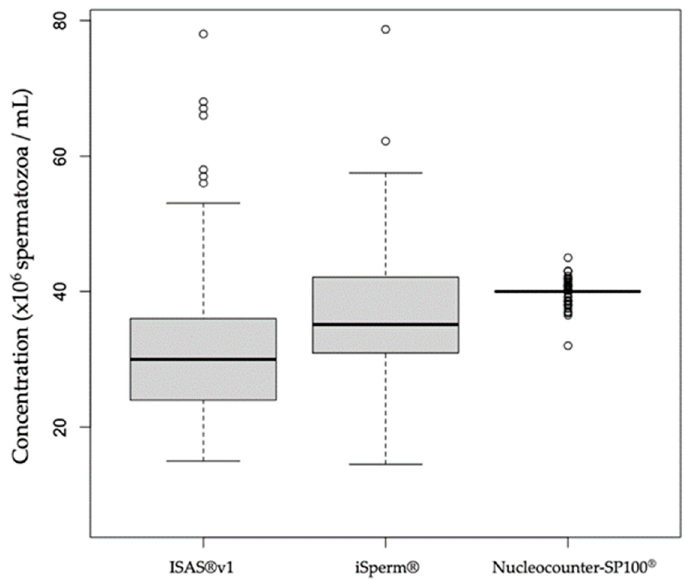
Figure 1. Box plots representing semen concentration measurements by ISAS ® v1 and iSperm ® in comparison to the set concentration of 40 × 10 6 /mL. The small circles represent outlier values.